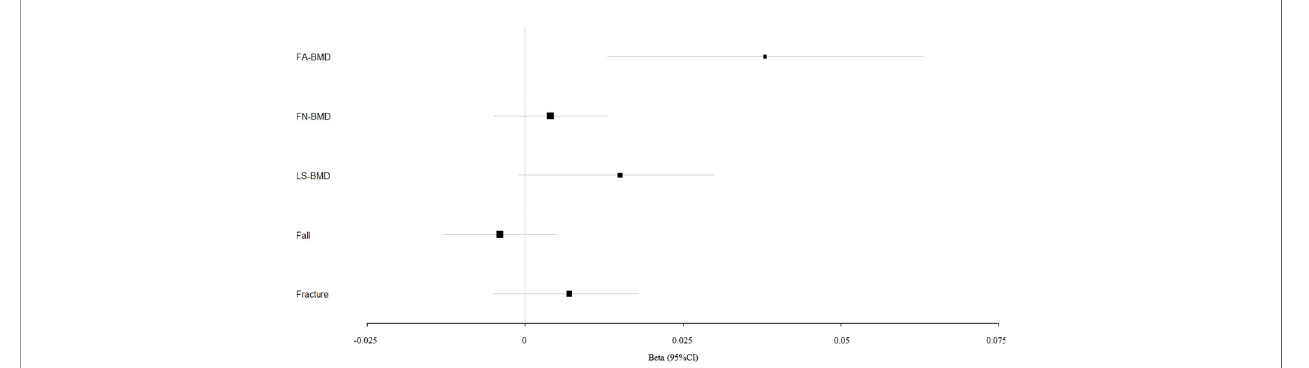
FIGURE 3 | Mendelian randomization estimates for the associations between PP and outcomes. FA-BMD, forearm BMD; FN-BMD, femoral neck BMD; LS-BMD, lumbar spine BMD; CI, con fi